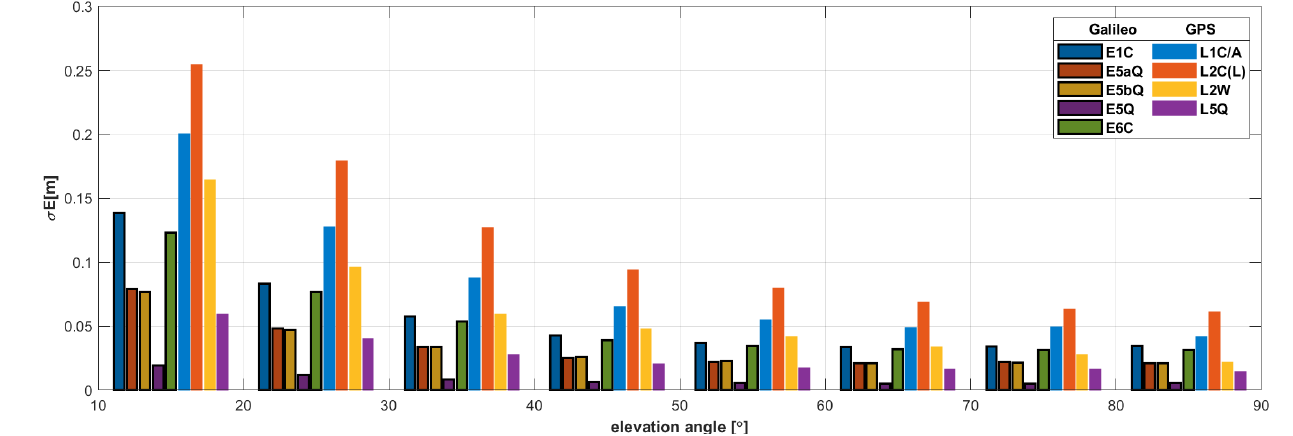
Figure 3. Standard deviation of pseudorange noise versus elevation at the WUT2 site.